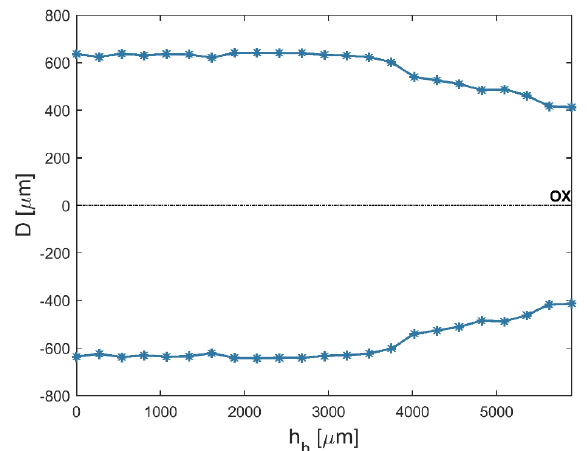
Figure 5. The profile of the drilled hole for the minimum value of applied current amplitude I = 3 A, U = 100 V, t i = 550 μs, and aspect ratio AR = 6.